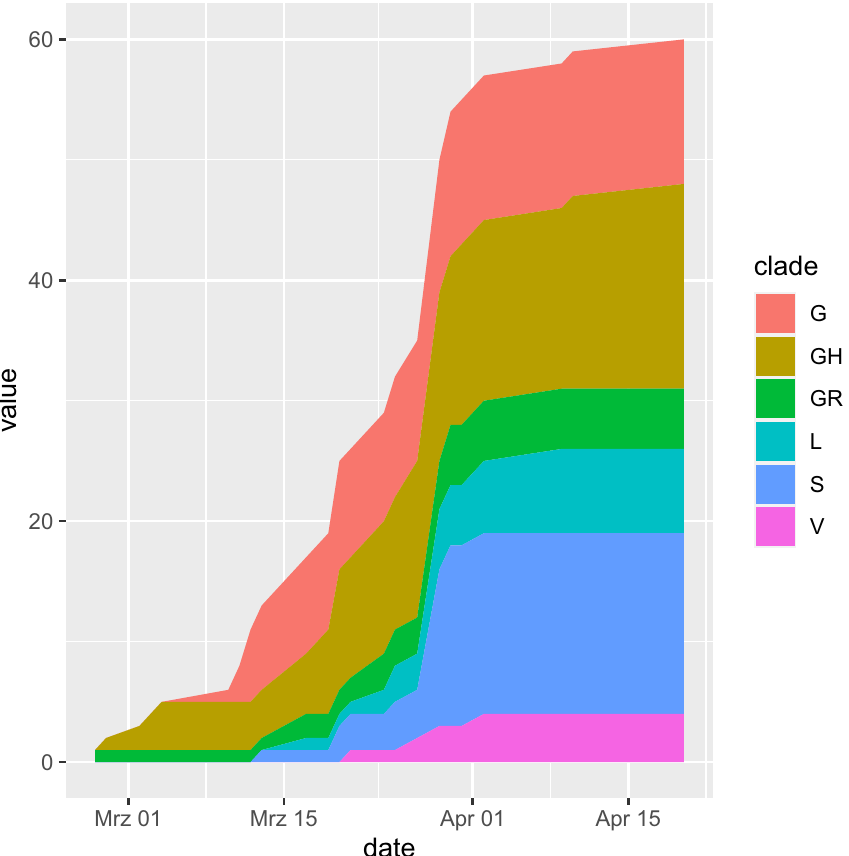
Figure 3. Temporal course of clade distribution confirms gaining of share of the Europe-associated G-clades harboring the putatively more infectious D614G amino acid substitution (February–April 2020). Interestingly the younger Europe-associated G-clades emerged earlier in West African sequenced samples. This could be due to founder effects by introductions from France being closely connected to Senegal and displaying a similar clade distribution. Furthermore, the China-based L-, V- and S-clade samples started in mid-March at a time when the epidemic in China was nearly entirely suppressed. Thus, the virus may have circulated in several countries before the first samples were sequenced. Surprisingly, the abundance of the S-clade is relatively high mainly due to Nigeria and Ghana but without that exception the clade distribution resembles the global one with a delay of about 2–4 weeks. The plot was generated using R (version 3.6.1, https:// www.r- proje ct. org/), [Ihaka, R. & Gentleman, R. R: A language for data analysis and graphics. J. Comput. Graph. Stat . 5 , 299–314 (1996)] and the R package ggplot2 (version 3.3.0, https:// ggplo t2. tidyv erse. org/) [Wickham, H. Ggplot2: Elegant Graphics for Data Analysis . (Springer,